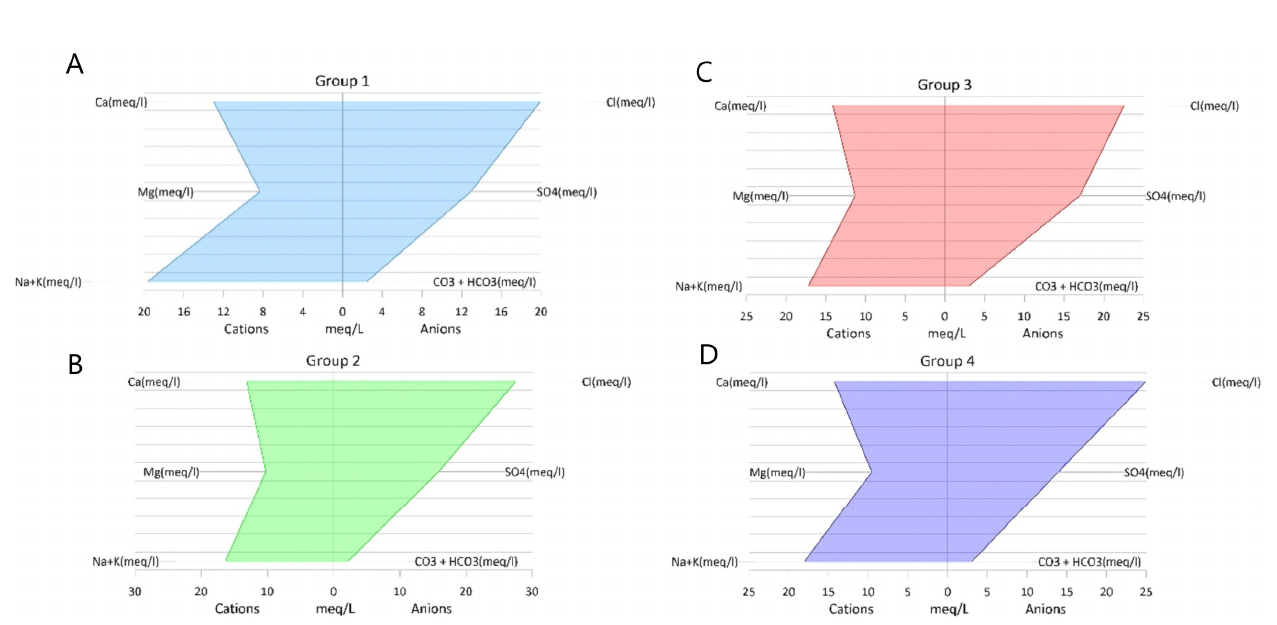
Figure 5. Stiff diagram for the four water groups, ( A ) group 1; ( B ) group 2; ( C ) group 3; ( D ) group 4.